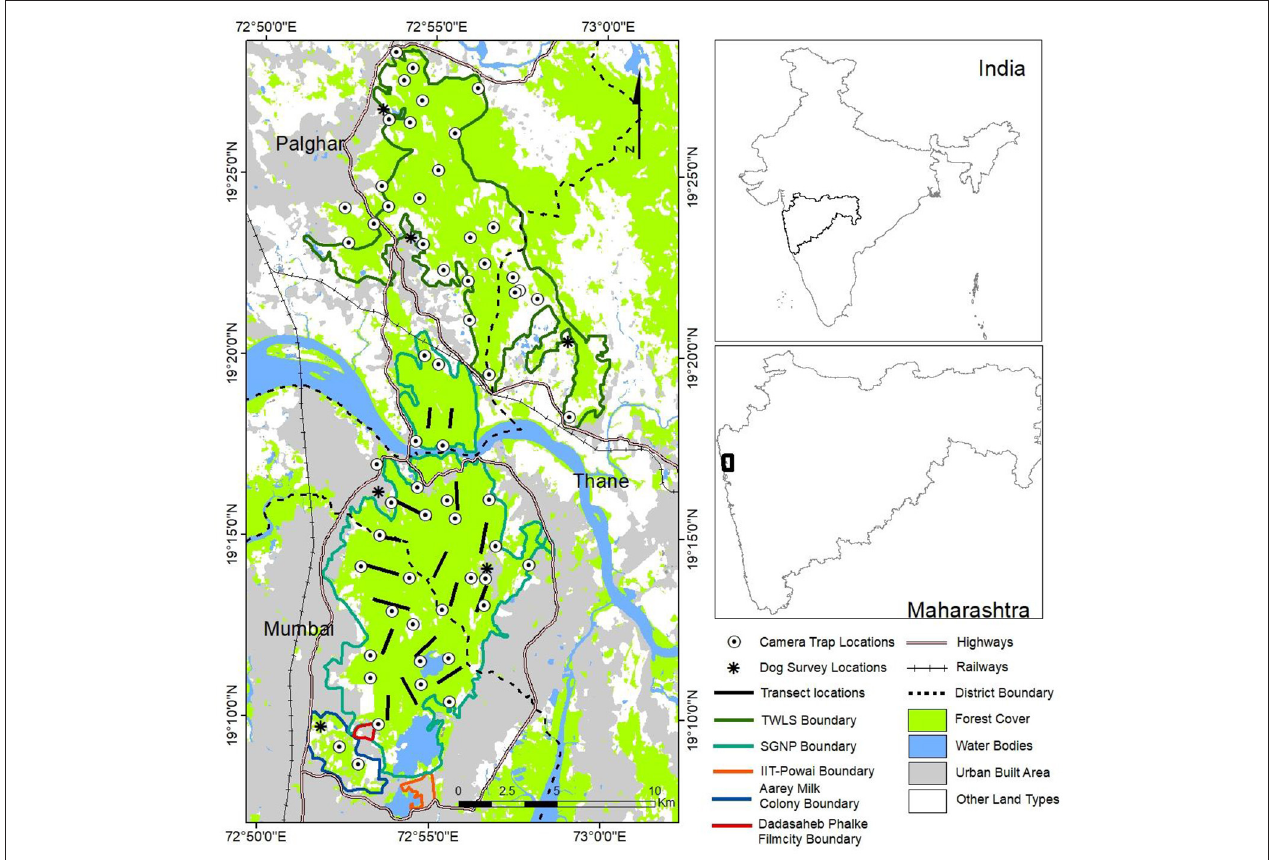
FIGURE 1 | A map of Sanjay Gandhi National Park and Tungareshwar Wildlife Sanctuary showing camera trap locations, line transects and dog survey